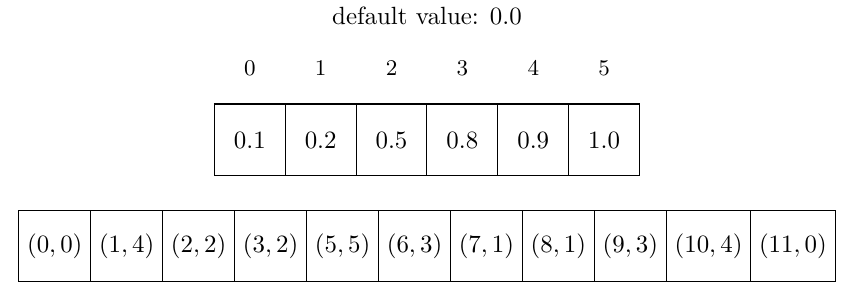
Figure 9. φ ( X 1 , X 2 , X 3 ) as IDP